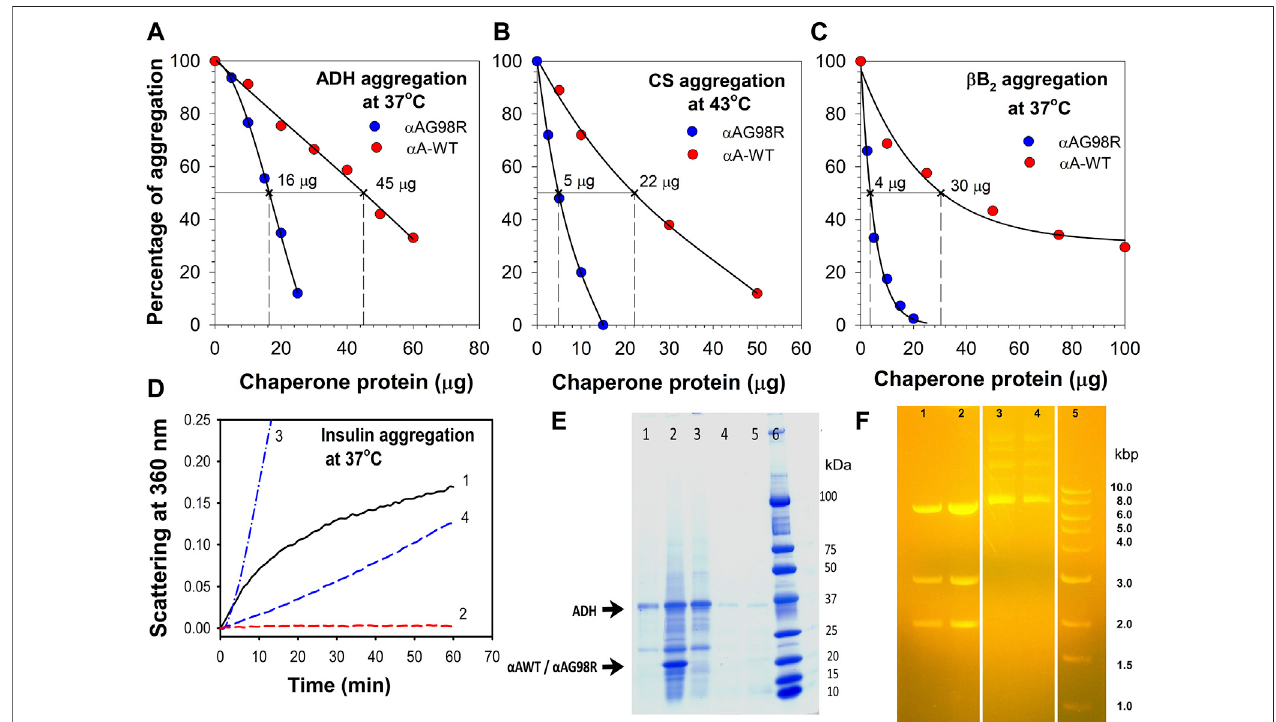
FIGURE1| Relativefunctionalactivityof α AG98Rand α A-WTproteins.Thechaperoneactivityof α AG98Rand α A-WTproteinwascomparedat60 minassaypoint and tested against — (A) , EDTA-induced aggregation of ADH at 37 ° C; (B) , thermal-induced aggregation of CS at 43 ° C; (C) , β B 2 -crystallin aggregation at 37 ° C. The aggregation of substrate protein shown at each concentration of chaperone protein tested is relative to the aggregation of substrate protein without the chaperone protein. The substrate protein aggregation (scattering at 360 nm) in the absence of chaperone protein is considered 100% aggregation. The EC 50 values were calculated from the non-linear regression analysis obtained by plotting the % of substrate protein aggregation for a known chaperone protein concentration. Sigma plot (Version 12.5) (Systat Software Inc., Palo Alto, CA, United States) dynamic curve fi tting with four-parameter logistic curve function was used for estimating EC 50 values. The result shown is representative of three independent experiments. (D) , Relative chaperone activity of α AG98R and α A-WT towards DTT-induced insulin aggregation at 37 ° C. Curve1 — Insulin (0.15 mg);Curve 2 — Insulin (0.15 mg) + α A-WT(0.15 mg);Curve 3 — Insulin(0.15 mg) + α A-G98R (0.15 mg);Curve 4 — Insulin(0.15 mg) + α A- G98R(0.30 mg). (E) ,SDS-PAGE analysisofchaperone assay samplesleft overnight at room temperature. ADH (0.1 mg) aggregation wasperformed in1.0 mlbuffer as describedundermethodsandinthepresenceof0.050 mgof α AG98Ror α A-WTproteinfor1 h(toachieve100%suppressionofADHaggregation).Theassaytubesleft overnight at room temperature were centrifuged at 1,000 x g for 10 min to collect the pellet. 15.0 µl of the supernatant (without adjusting the sample volume after removing the sediments) and the entire pellet after solubilizing in 30 µl of loading dye were analyzed by SDS PAGE. Lane 1 — [ADH + α A-G98R] supernatant; Lane 2 — [ADH+ α AG98R]pellet;lane3 — ADH — 2.5 µg;Lane4 — [ADH+ α A-WT]pellet;Lane5 — [ADH+ α A-WT]Supernatant.ThesmallimpuritiespresentintheADH(lane3)are unlikelytochangetheobservedresults. ThestrongbandforADHinlane1suggeststhatasigni fi cantamount oftheprotein remained solublewithoutinteractingwiththe chaperone protein. (F) α AG98R protects SmaI from thermal inactivation. Agarose gel electrophoresis showing the DNA digestion pro fi le of SmaI heated at 37 ° C